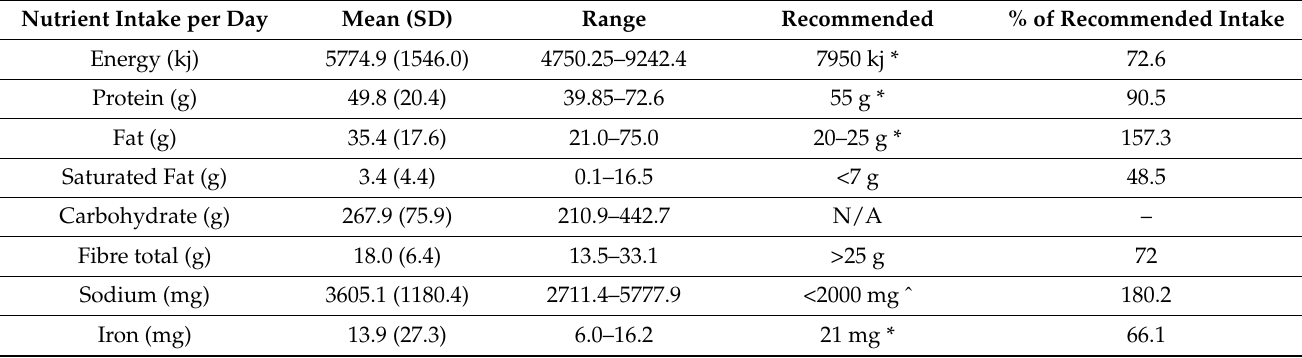
Table 3. Mean daily intakes using Indian food composition tables and comparison with Indian Council of Medical Research recommendations * ( n =